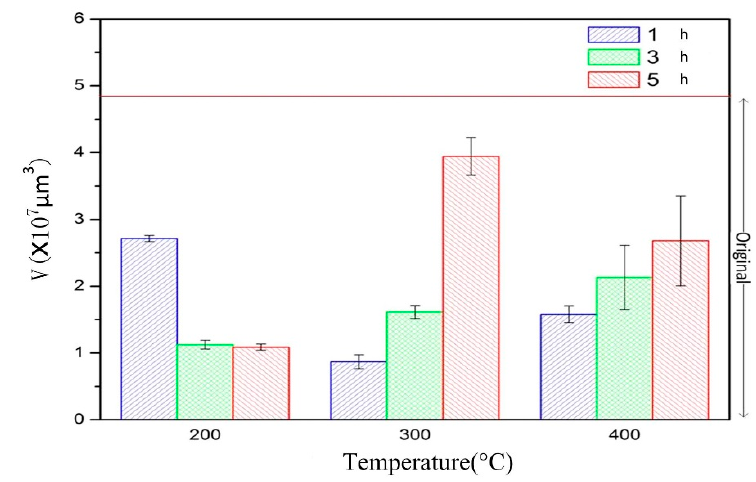
Figure 9. Wear volume of oxidized coatings under various thermal-oxidation treatments.